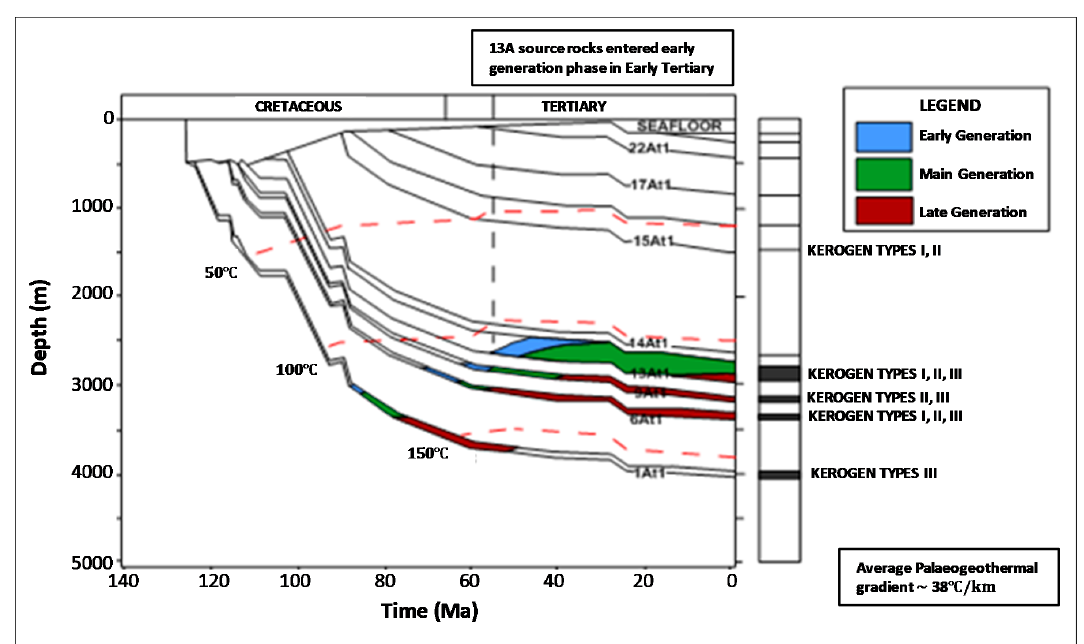
Figure 3. Schematic diagram showing Burial history graph for Bredasdorp Basin [41].